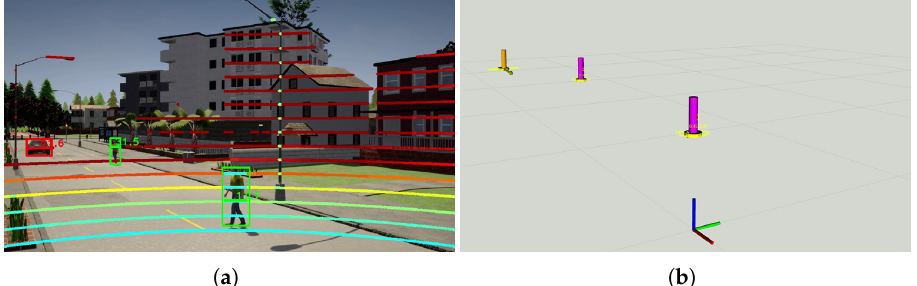
Figure 17. Pedestrian detection and tracking in the IRSU in the CARLA simulator. Despite dual cameras enabled for detecting road users in the IRSU, the Cam #1 captured all the road users at the particular moment in the experiment. Therefore, only the image frame from that camera is shown in ( a ). In ( b ), where the road users are tracked in 3D space, the CAV itself is labelled as an orange pillar with a confidence ellipse and an arrow indicating its moving direction. The two pedestrians are denoted by magenta